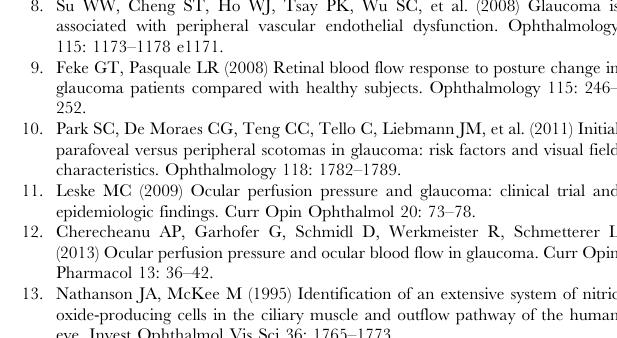
Figure S3 Fluorescein angiography in WT and sGC a 1 2 / 2 mice. A : Serial images (A–G) of fluorescein angiography between 1 and 3 seconds after I.V. injection of fluorescein. Retinal arterioles (arrows in panel A ) were identified based on earlier filling with fluorescein than veins (arrows in panel E ). B : Image of fluorescein angiography. The width of the arterioles was de- termined (boxes) at fixed distances from the optic nerve head (inner dashed ring = 150 m m; outer dashed ring = 250 m m). C : Quantitative analysis of the diameter of retinal arterioles in wild type (WT, left panel ) and soluble guanylate cyclase a 1 -deficient mice (sGC a 1 2 / 2 , middle panel ) before and after a challenge with 0.8 mg/kg sodium nitroprusside. Baseline diameter of retinal arterioles was similar in WT and sGC a 1 2 / 2 mice ( P = 0.40). Injection of 0.8 mg/kg sodium nitroprusside reduced the diameter of retinal arterioles in both WT (* P =7.8 6 10 2 12 ) and sGC a 1 2 / 2 mice (* P = 1.7 6 10 2 6 ). The change in diameter induced by injection of sodium nitroprusside was more pronounced in WT than in sGC a 1 2 / 2 mice ( right panel , * P = 9.0 6 10 2 6 ). n = 17 and 15 WT and sGC a 1 2 / 2 arterioles, respectively; 3–4